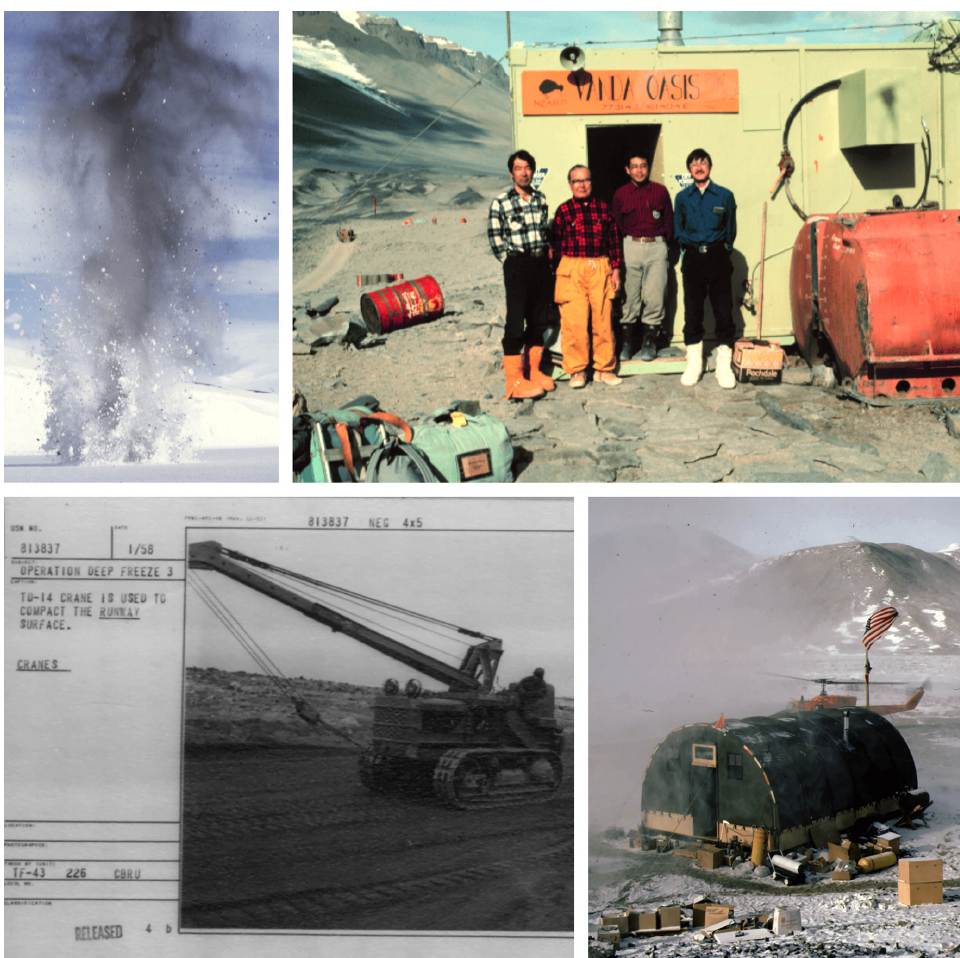
Figure 1. Examples of photographs from the archive showing human activity in the MDV. Unless otherwise stated, copyright for each item remains with the respective contributor. Detailed metadata for each item are available on the archive website (http://mcmurdohistory.lternet. edu) and the Environmental Data Initiative (Howkins et al.,